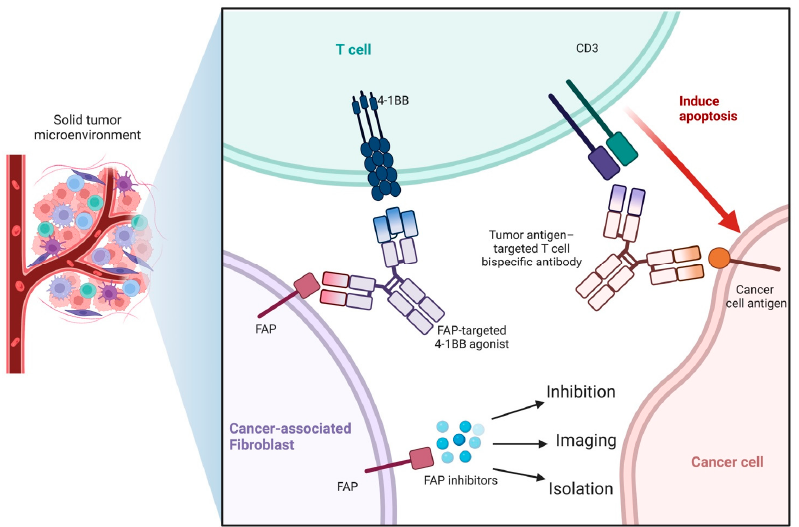
Figure 1. Interaction between FAP and FAPI in the solid tumor microenvironment. Tumor-targeted therapy could be achieved by FAP recognition and inhibition via 4-1 BB bispecific agonists, indicat- ing the therapeutic value of FAPI.